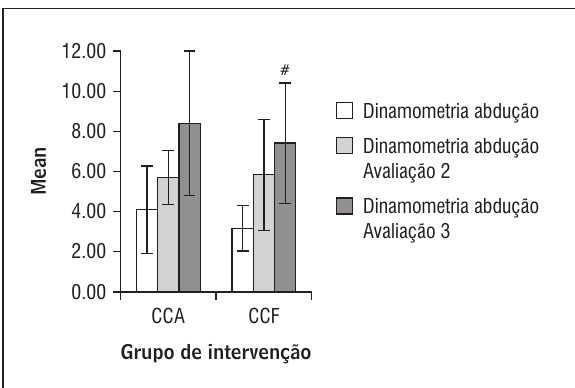
Figura 3 - Análise da força dinamométrica de abdução do ombro (kg) Legenda: # p = 0,05 avaliação inicial para avaliação fi nal.